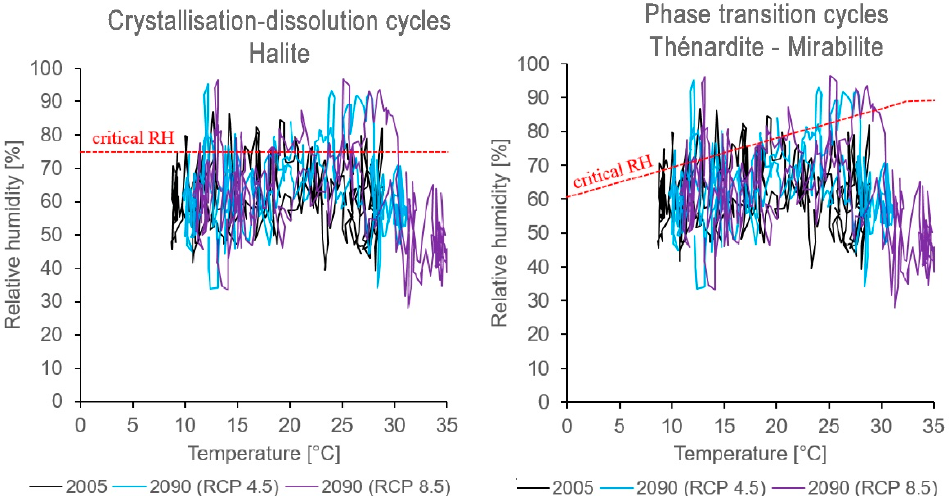
Figure 19. T s and RH daily profile versus critical RH for Halite deliquescence ( left ) and Thénardite to Mirabilite phase transition ( right ) for the different scenarios analysed.